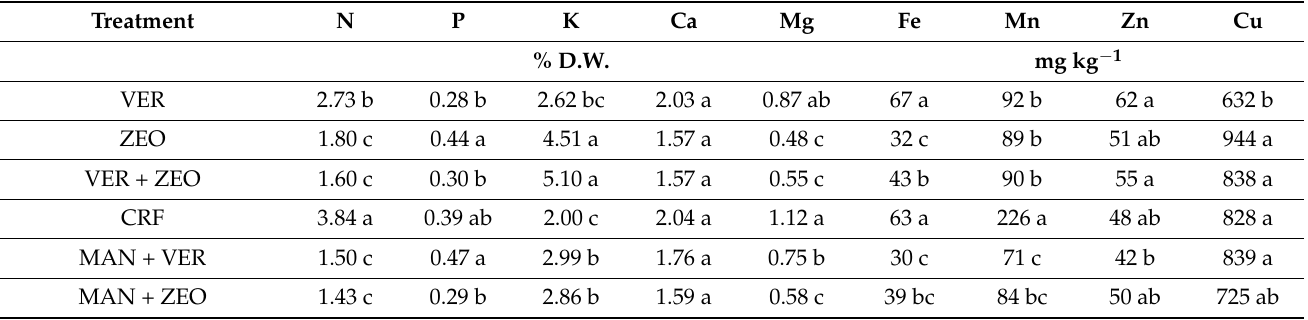
Table 3. Foliar nutrient concentrations in pepper plants among the treatments.